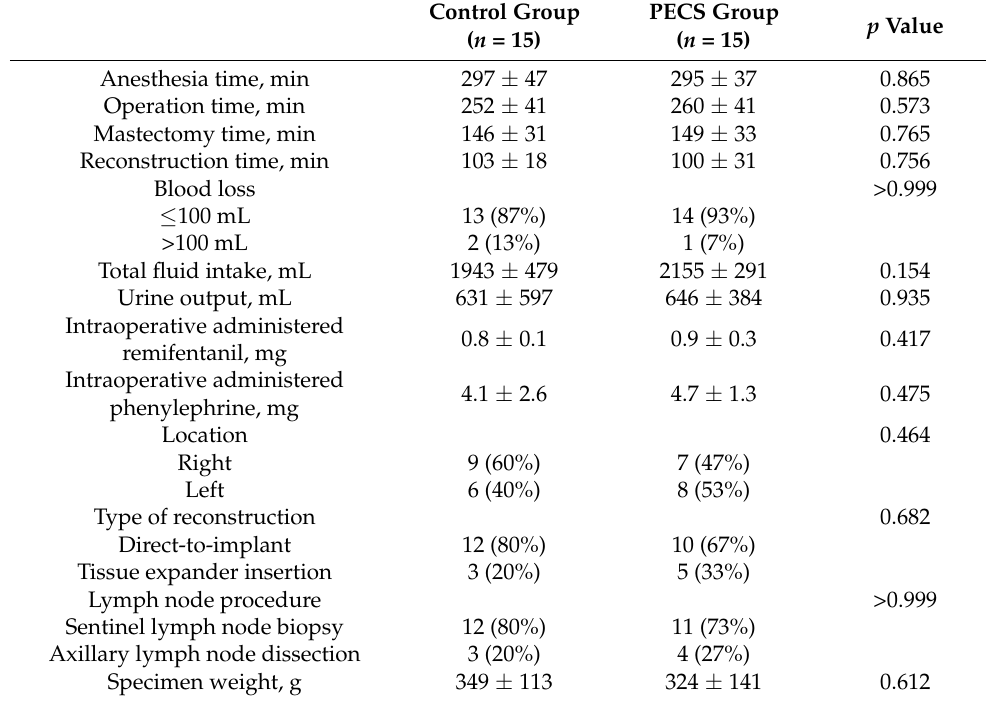
Table 2. Intraoperative and surgical